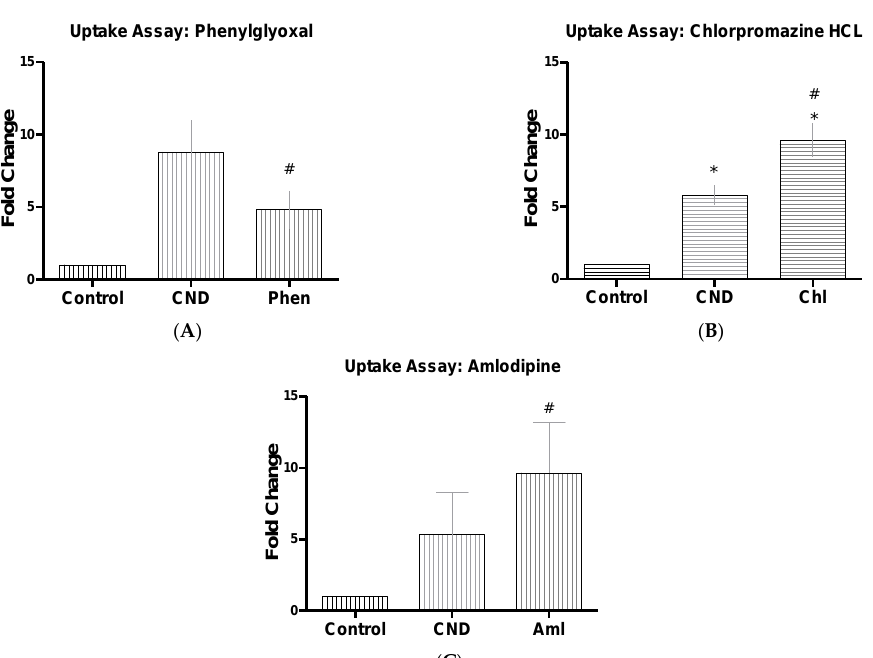
Figure 7. CND uptake. HMEC-1 cells were treated with inhibitor Phen ( A ), Chl ( B ) and Aml ( C ) with concentrations described (Table 1) for 30 min. Cells were then washed two times with PBS and treated for 6 h, with 0.1 mg/mL of CNDs. After CND treatment, cells were washed two times with PBS.